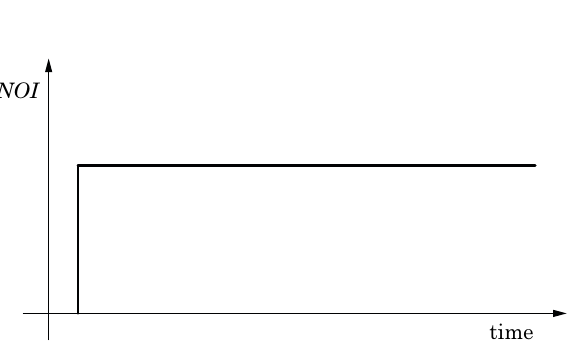
fig. 2. Direct capitalization based on the dividend discount model (formula 2)